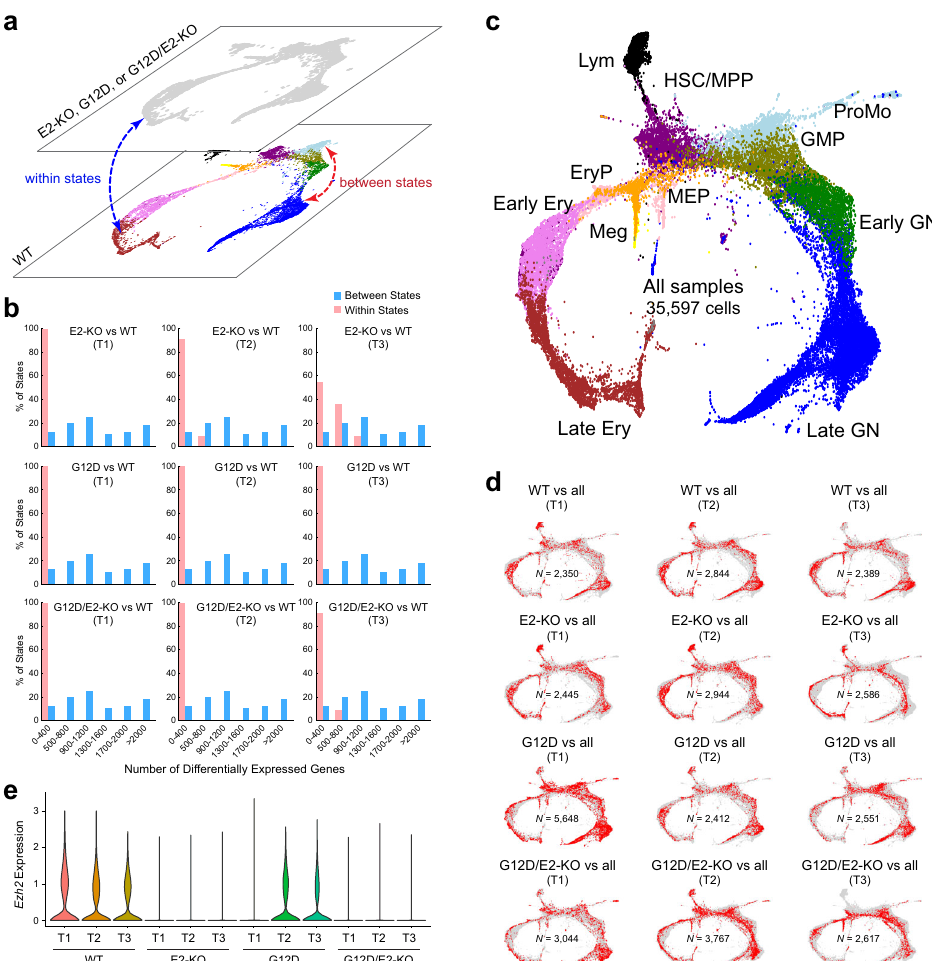
Fig. 2 Identi fi cation of cellular composition in mutant HSPCs. a Annotation of cell populations in mutant HSPCs. The cell state for each cell from E2-KO, G12D, or G12D/E2-KO mutant HSPCs was annotated based on the cell state of their nearest neighbor in WT HSPCs. The differentially expressed genes (DEGs) between WT and mutant HSPCs within the same cell state (within states) or between states within the same genotype (between states) were identi fi ed by Wilcoxon rank sum test (adjusted P value < 0.01). b Number of DEGs within and between cell states. Histograms show the numbers of DEGs between WT and mutant HSPCs within each cell state ( red ) or between different cell states ( blue ). c KNN visualization of all single cells by combining 12 samples. Each dot represents a single cell. Cells are colored by cell-type annotations. d KNN visualization of single cells from each sample. Each plot shows cells from the indicated genotype and time point ( red ) against all cells from other genotypes and time points ( gray ). e Violin plot is shown for Ezh2 mRNA expression in WT or mutant HSPCs at different time points (T1 – and erythroid cells, G12D/E2-KO HSPCs had signi fi cantly and progressively increased frequency of MEPs from T1 to T3 (Fig. 3e). Moreover, the ratio of megakaryocytes to erythroid cells also progressively increased from T1 to T3 during leukemia progression (Fig. 3f).